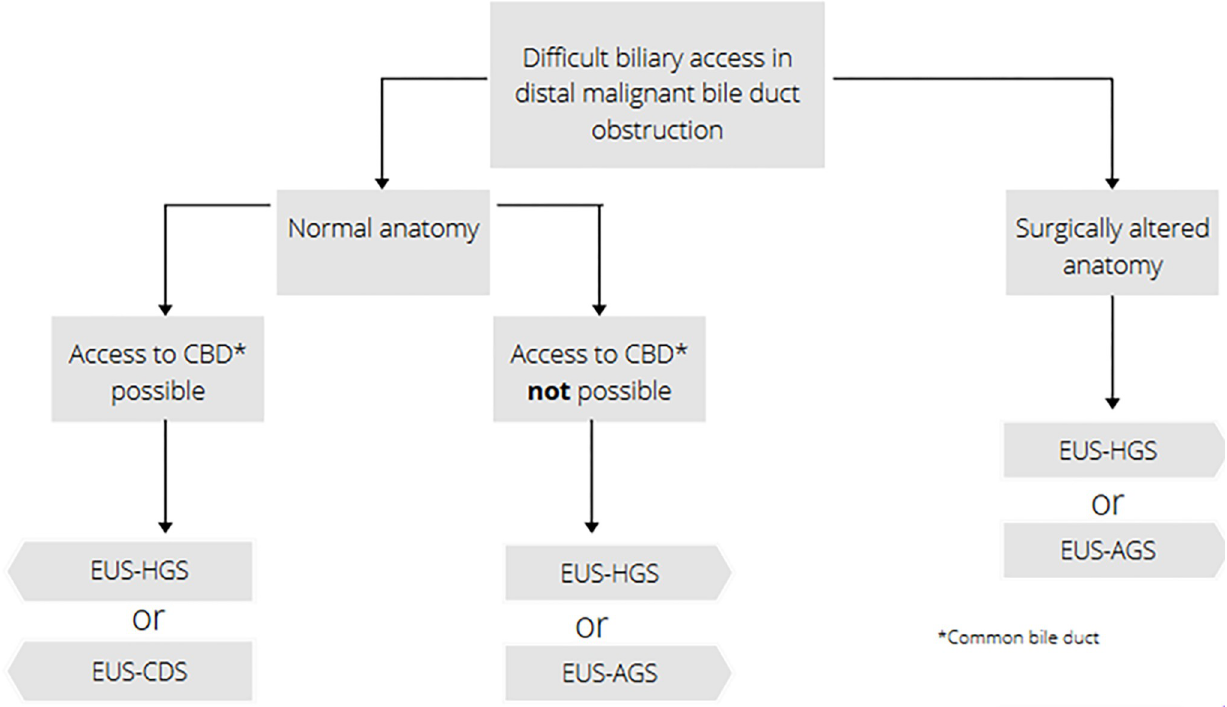
Fig 3. Algorithm for the selected EUS-BD procedure in distal, malignant bile duct obstruction.